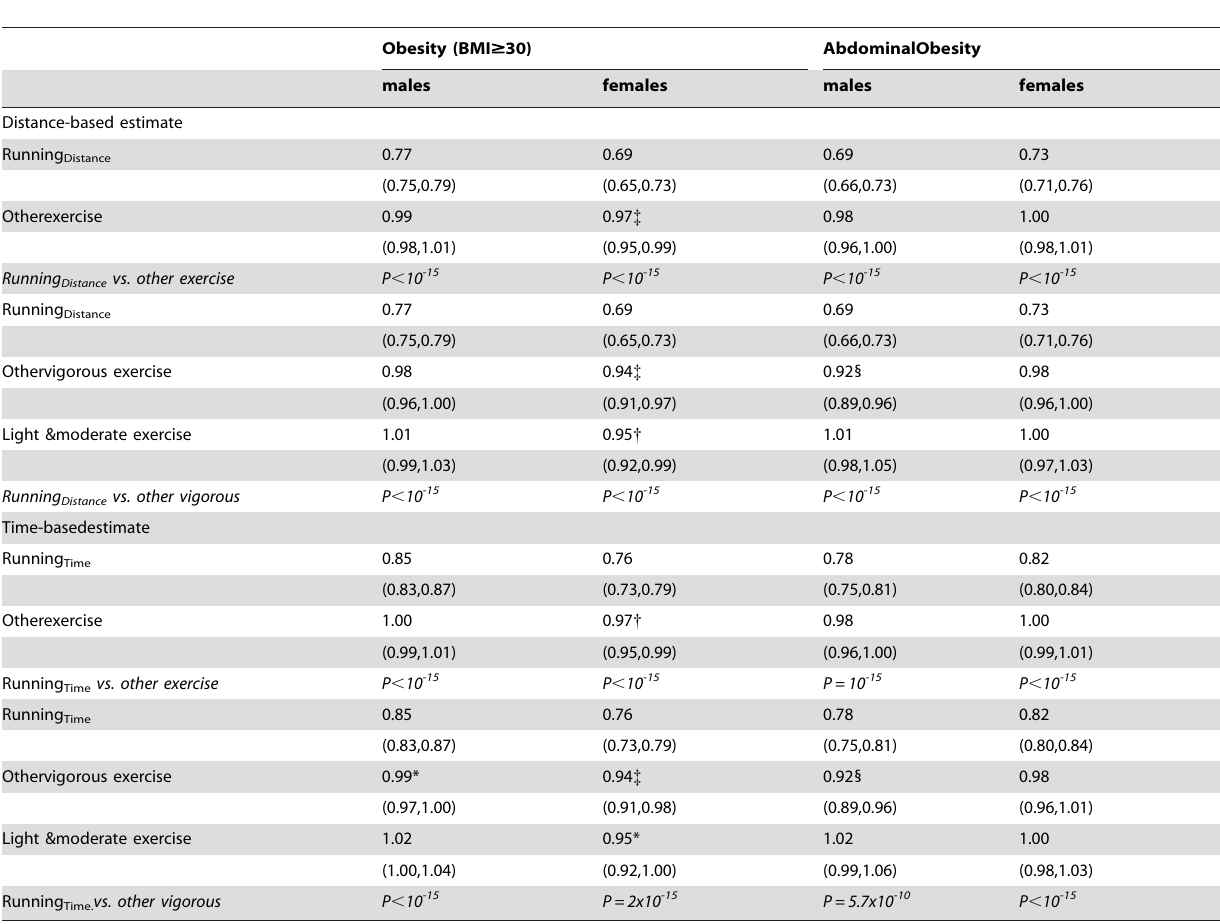
Table 5. Odds ratio (95% confidenceinterval) for obesity and abdominal obesity versus METhours per day ofrunning and other physical